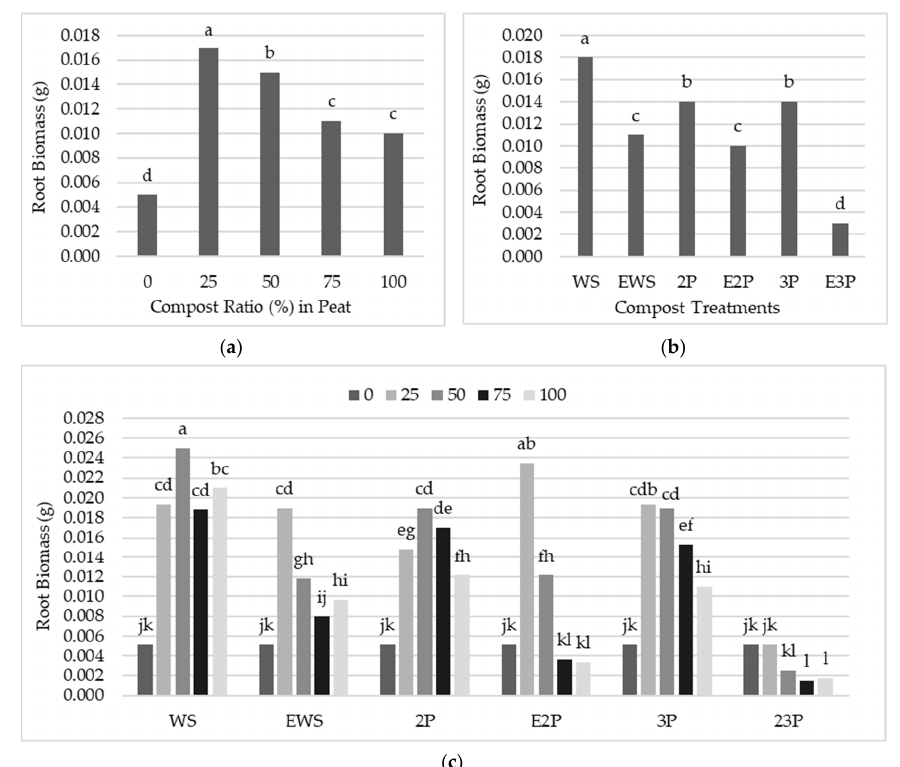
Figure 2. Main ( a , b ) and interaction ( c ) effects of the treatments on root dry weight. Means within each column followed by the same letters are not significantly different according to the Tukey test. Agronomy 2020 , 10 , x FOR PEER REVIEW